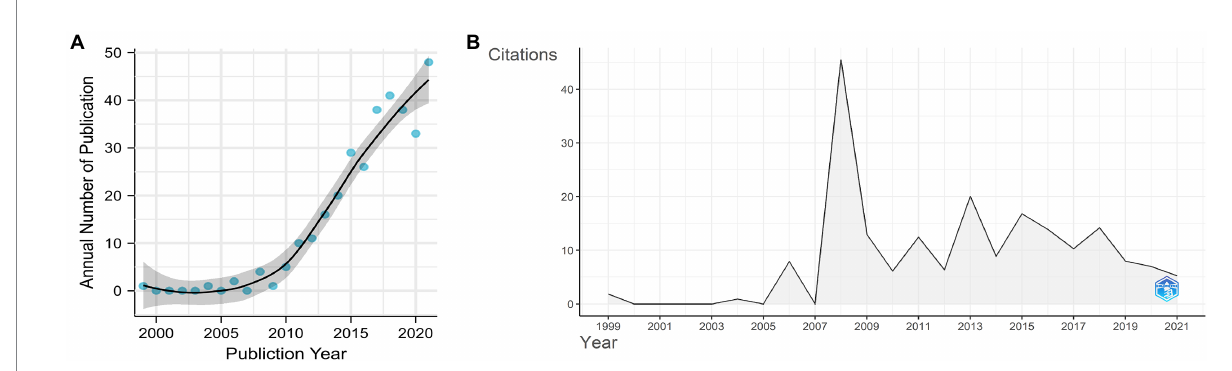
FIGURE 2 (A) Annual publication numbers and fit of the publication growth curve. (B) number of average citations per